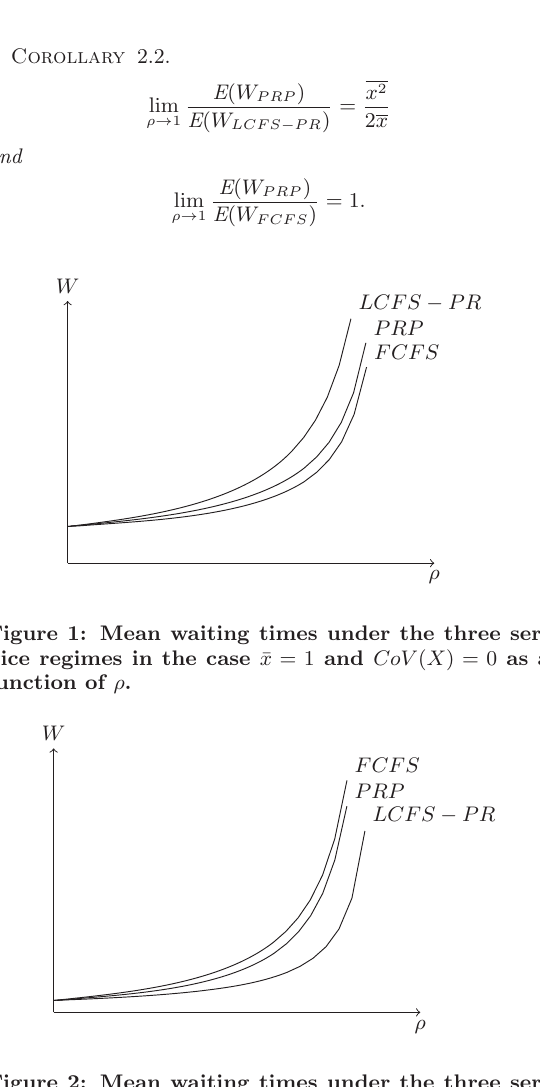
Figure 2: Mean waiting times under the three ser- vice regimes in the case ¯ x = 1 and CoV ( X ) = 2 as a function of ρ